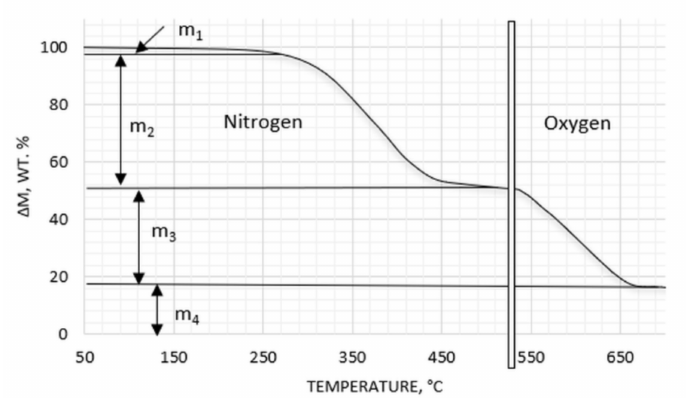
Figure 1. TGA analysis procedure used for the analysis of GTR samples. m 1 —low molecular weight organic substances and water, m 2 —rubber, m 3 —carbon black, m 4 —mineral